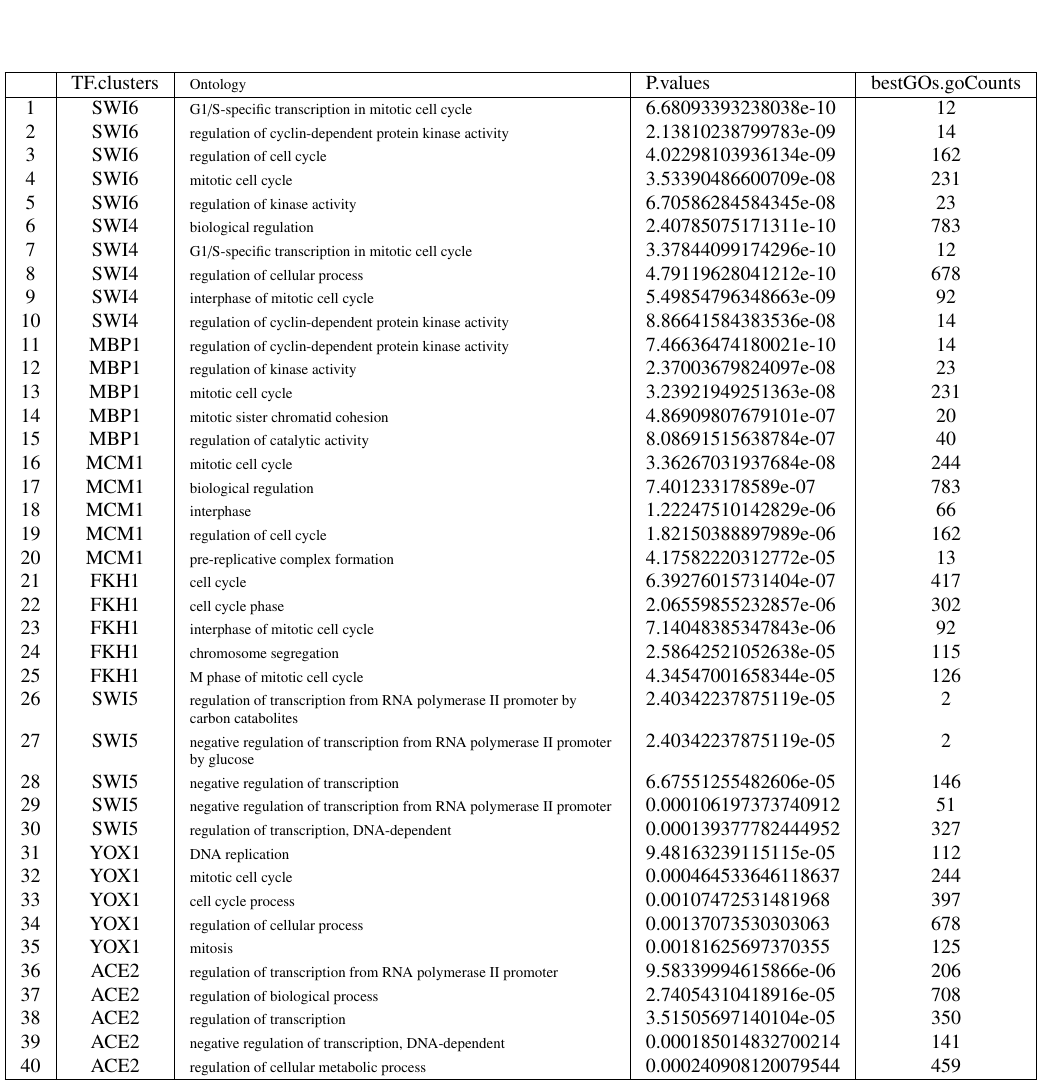
Table 1: GO enrichment analysis results for the eight hubs and their neighbours. Clusters Ontology